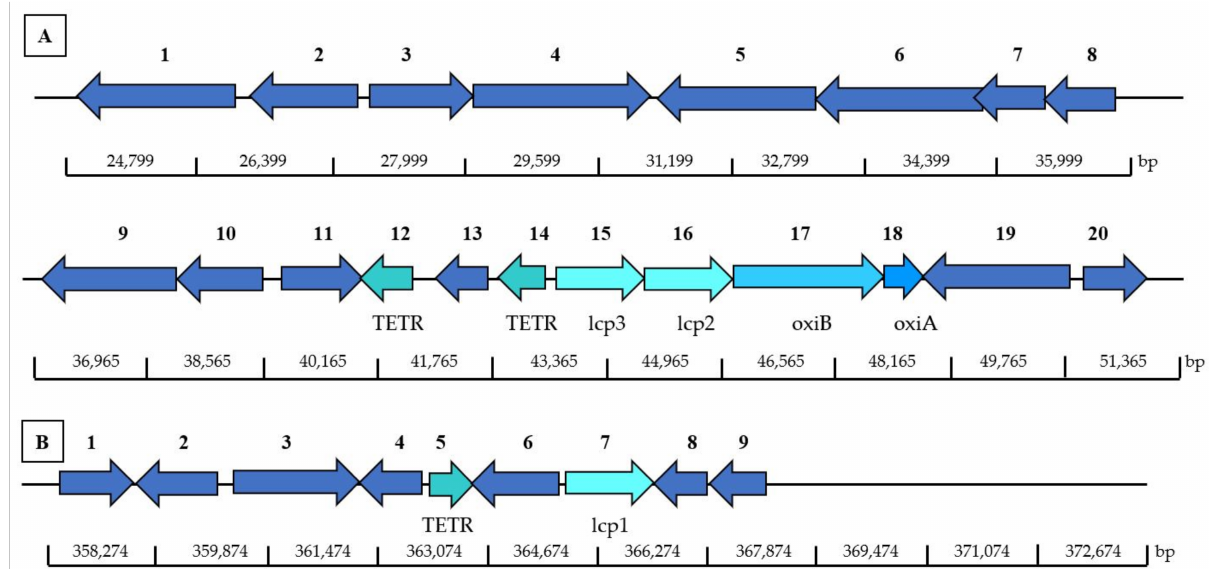
Figure 6. Location of lcp1 , lcp2 and lcp3 , and adjacent genes in Dactylosporangium sp. AC04546 located on chromosome: ( A ) Contig 82: 1, Long chain fatty acid CoA ligase (EC 6.2.1.3); 2, Transcriptional regulator, AcrR; 3, Acetyl-CoA